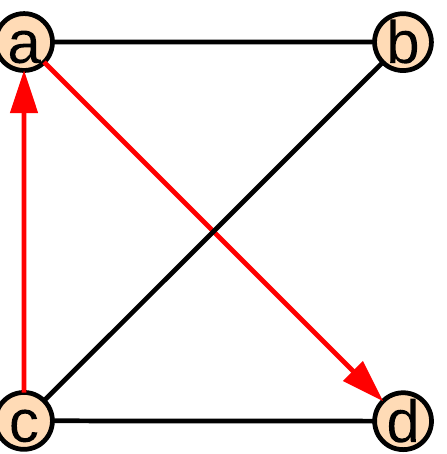
Figure 2. Example of a mixed graph M = ( V , E , A ) with vertex set V = { a , b , c , d } , edge set { ab , bc , cd } and arc set A = { (cid:126) ca , (cid:126) ad }